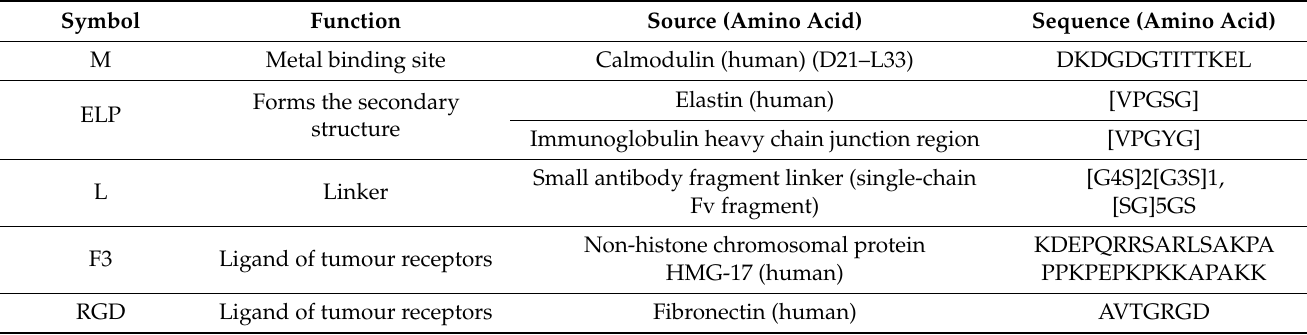
Table 2. Amino acid composition of the functional units of the designed